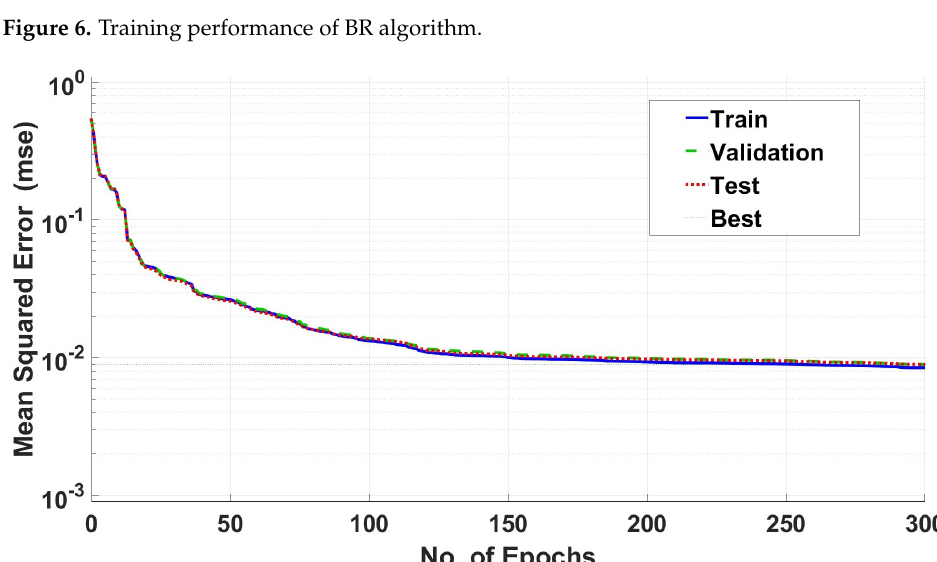
Figure 7. Training performance of SCG